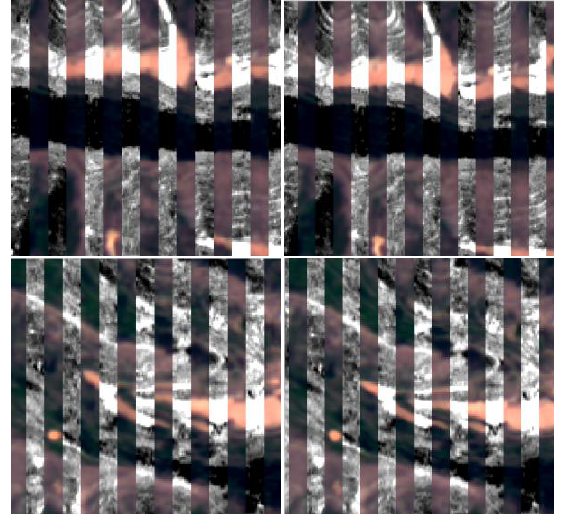
Figure 5. The co-registration result of ZY-images from different flights. The left column is produced by the parameterized method while the right column is produced by our non- parameterized